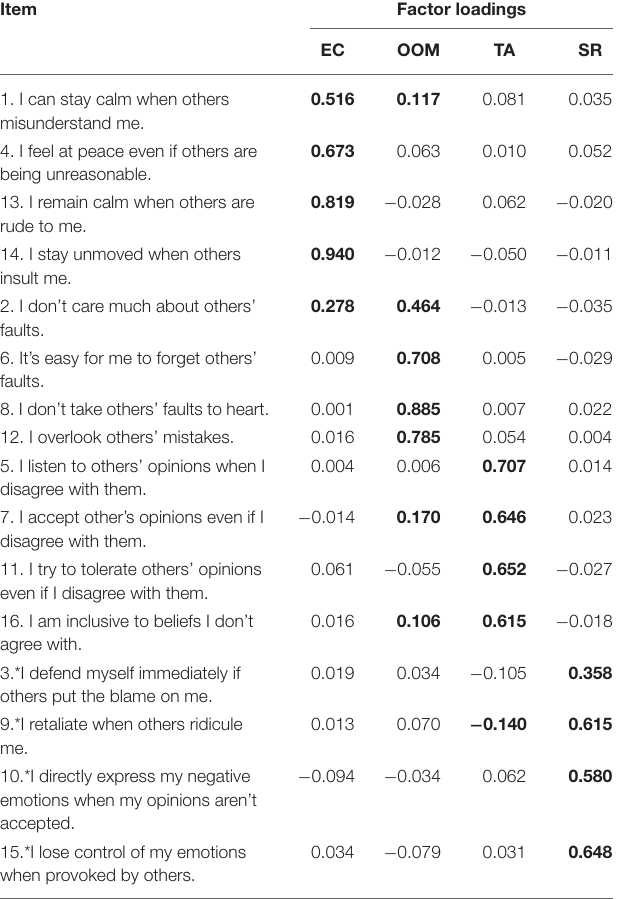
TABLE 1 | Results of exploratory factor analysis on the original Forbearance Scale. Item